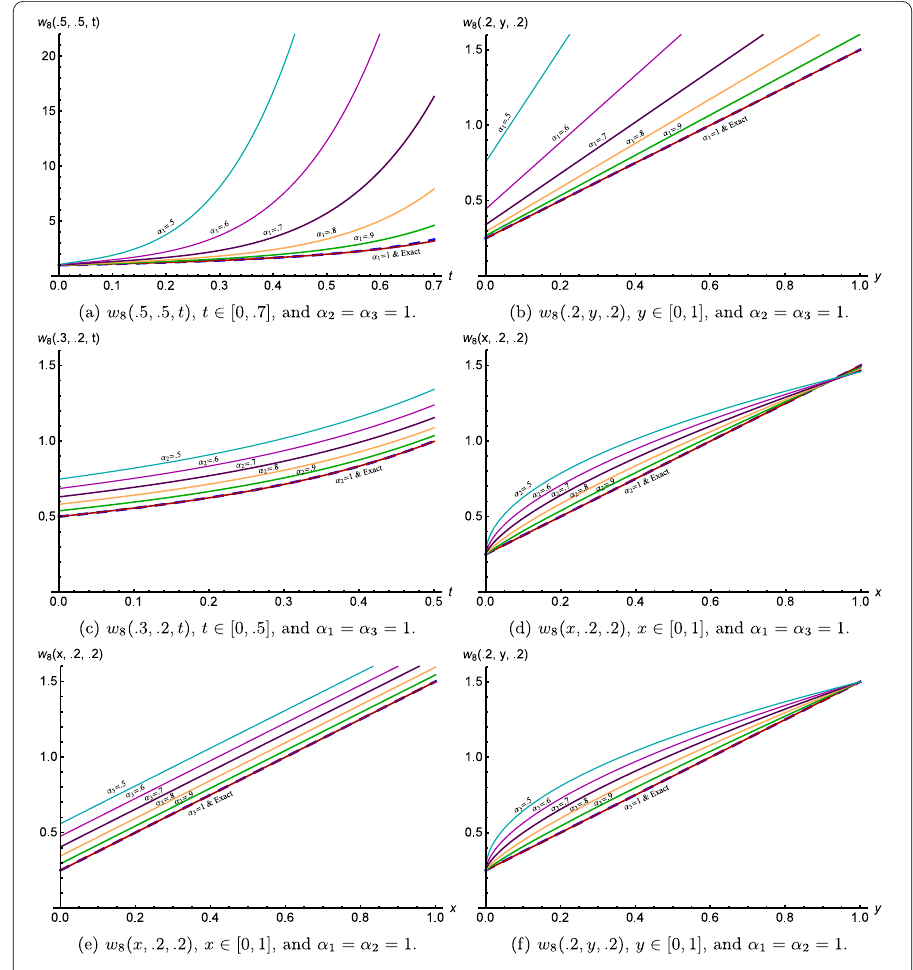
(cid:10) 8 i α 1 i =0 W ααα ( i ,1,0) t